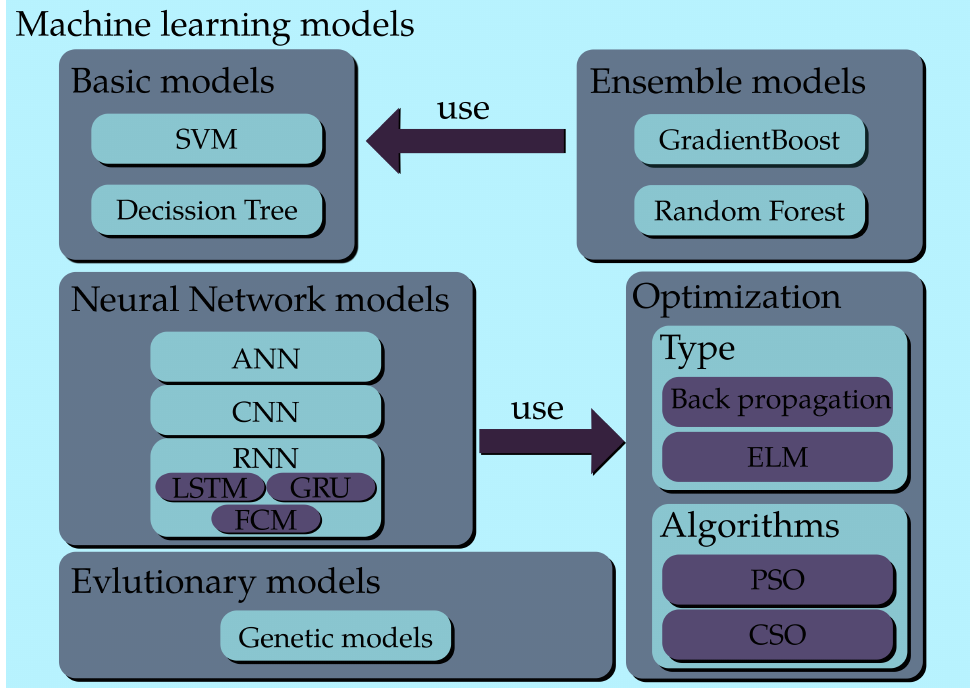
Figure 1. Machine learning models